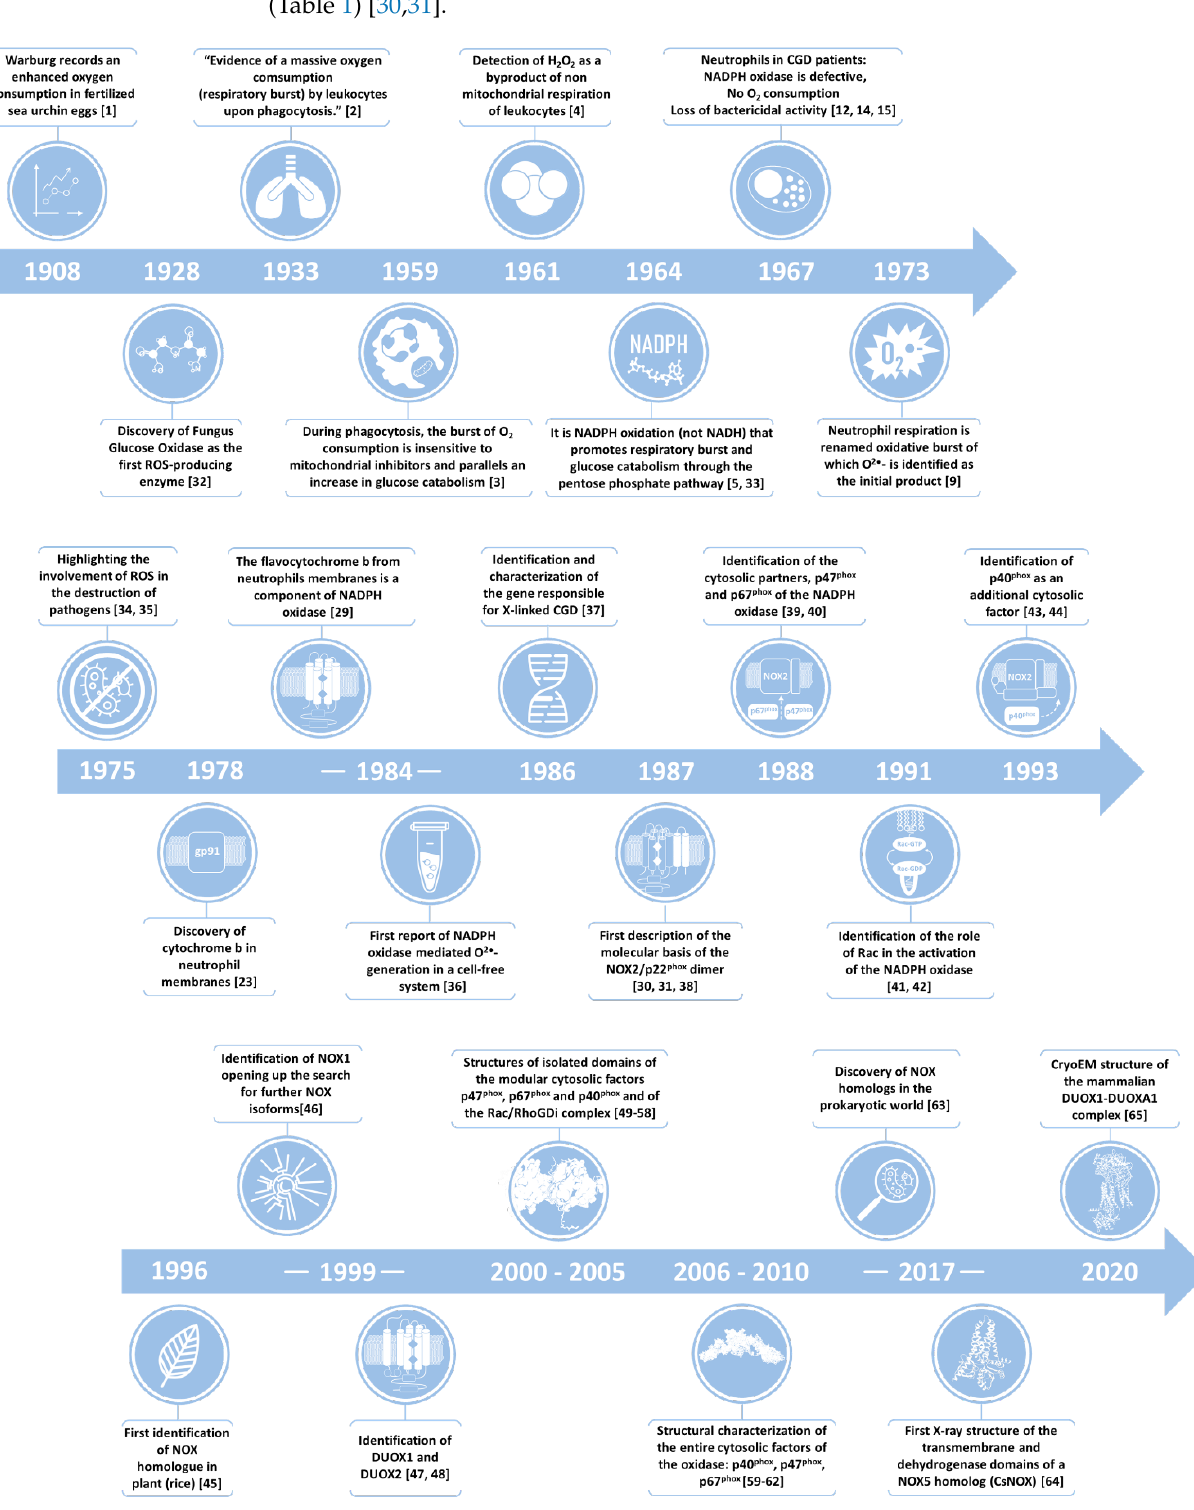
Figure 1. Timeline of the major steps leading to the identification and mechanistic description of the NADPH oxidase family of enzymes, specialized in the deliberate production of ROS [1–5,9,12,14,15,23,29–65]. NADPH oxidase was also commonly referred to as gp91 phox because isolated from phagocytes it appears at an apparent molecular weight of 91 kDa on SDS PAGE gels.